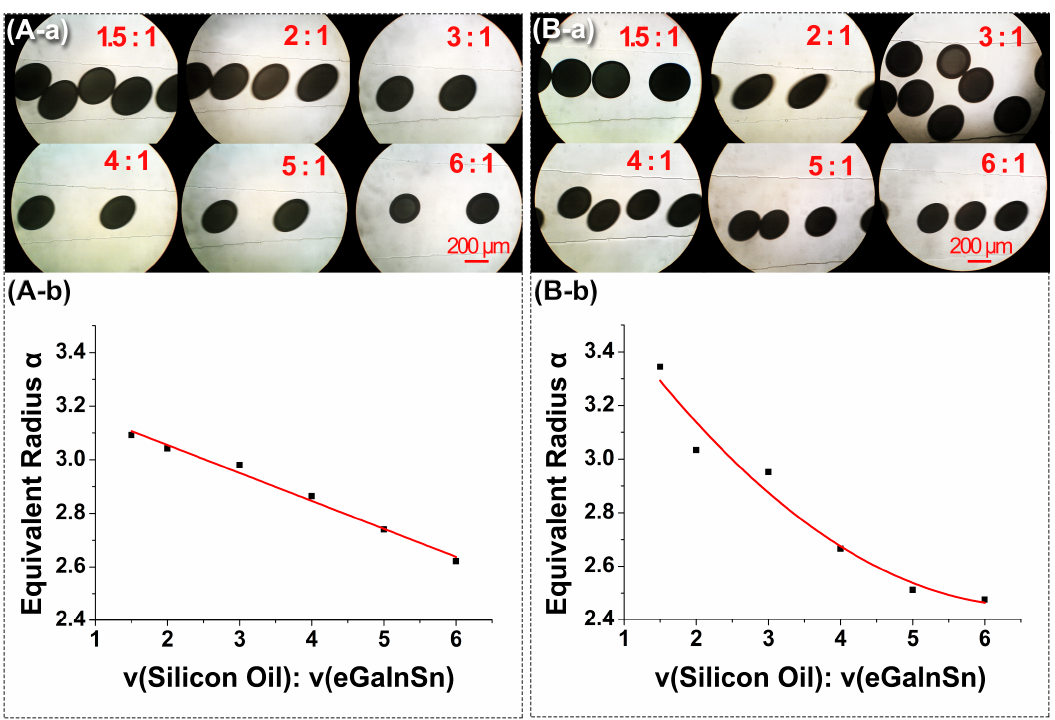
Figure 3. Three designs for droplet generation: ( A ) F 0 -type; ( B ) F 1 -type; ( C ) F 2 -type.